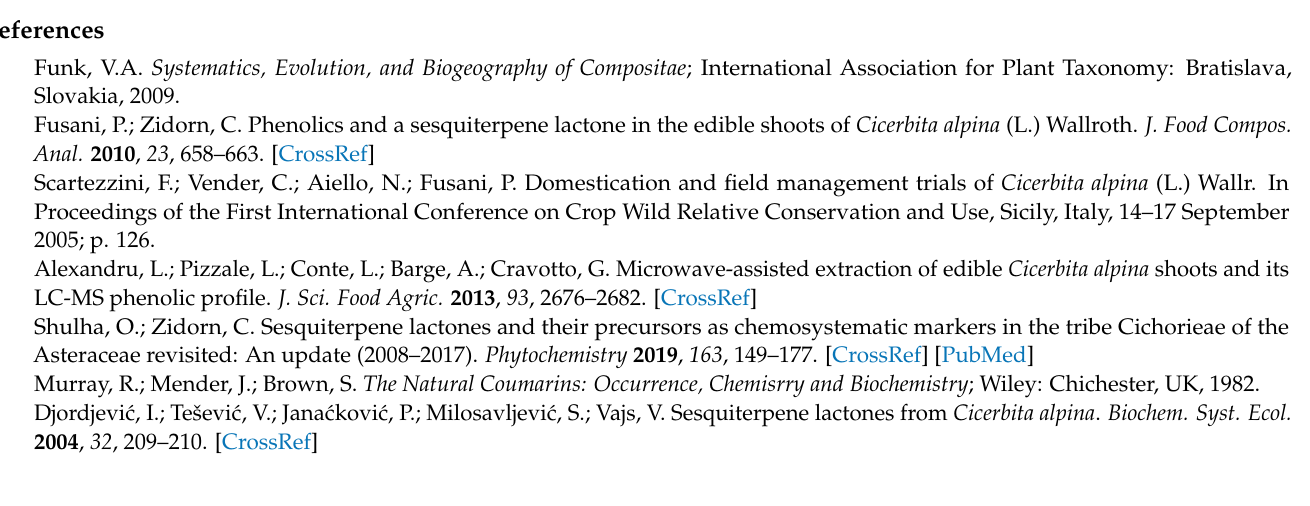
Figure S6: (+) ESI/MS-MS spectrum of 8-acetyl-11 β ,13-dihydrolactucin ( 103 ); Figure S7: (+) ESI/MS- MS spectrum of aesculetin ( 108 ); Figure S8. Variation of secondary metabolites among the studied C. alpina